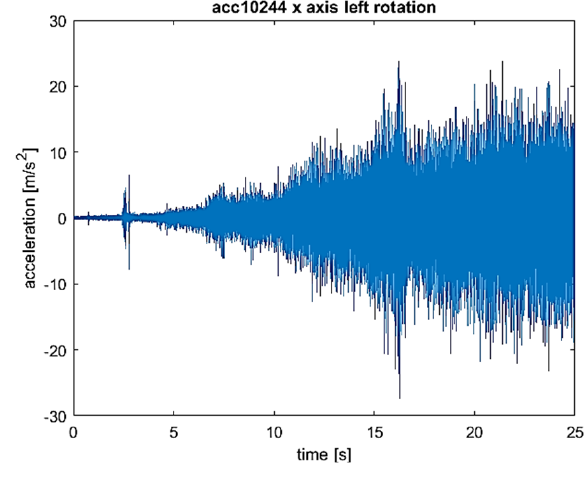
Figure 8. Location of the vibration and tachometric sensors used for the analytical experiment.